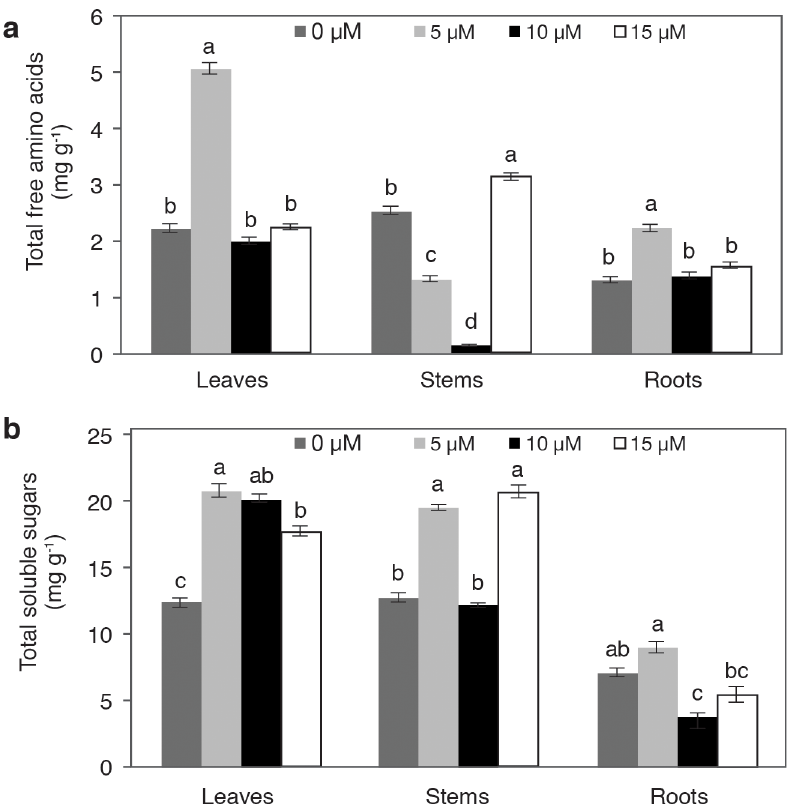
Fig 5. Concentrations of total free amino acids (a) and total soluble sugars (b) in leaves, stems and roots of pepper plants grown in nutrient solutions containing different concentrations of vanadium (0, 5, 10 and 15 μ M V) during 28 d. Values are means ± standard error (SE) from at least five individual plants. Different letters above the bars for the individual plant parts indicate significant differences (Duncan, α = 0.05).